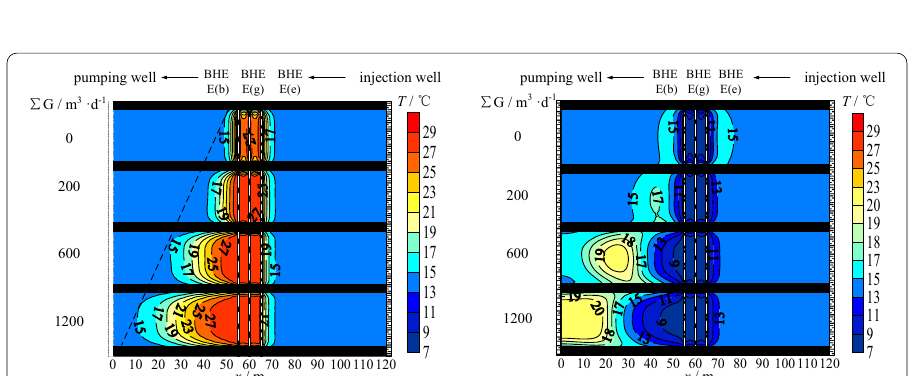
Fig. 10 Profile temperature field in the fine sand aquifer under the different total pumping–injection flow volume: a the end of the cooling stage (120 d); b the end of the heating stage (300